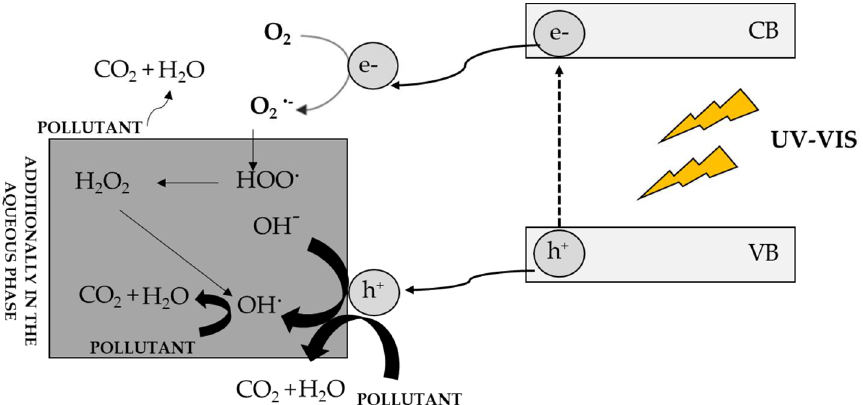
Figure 4. Mechanism of photocatalyst excitation and photodegradation of contaminants in the aque- ous and gas phases [3]. aqueous and gas phases